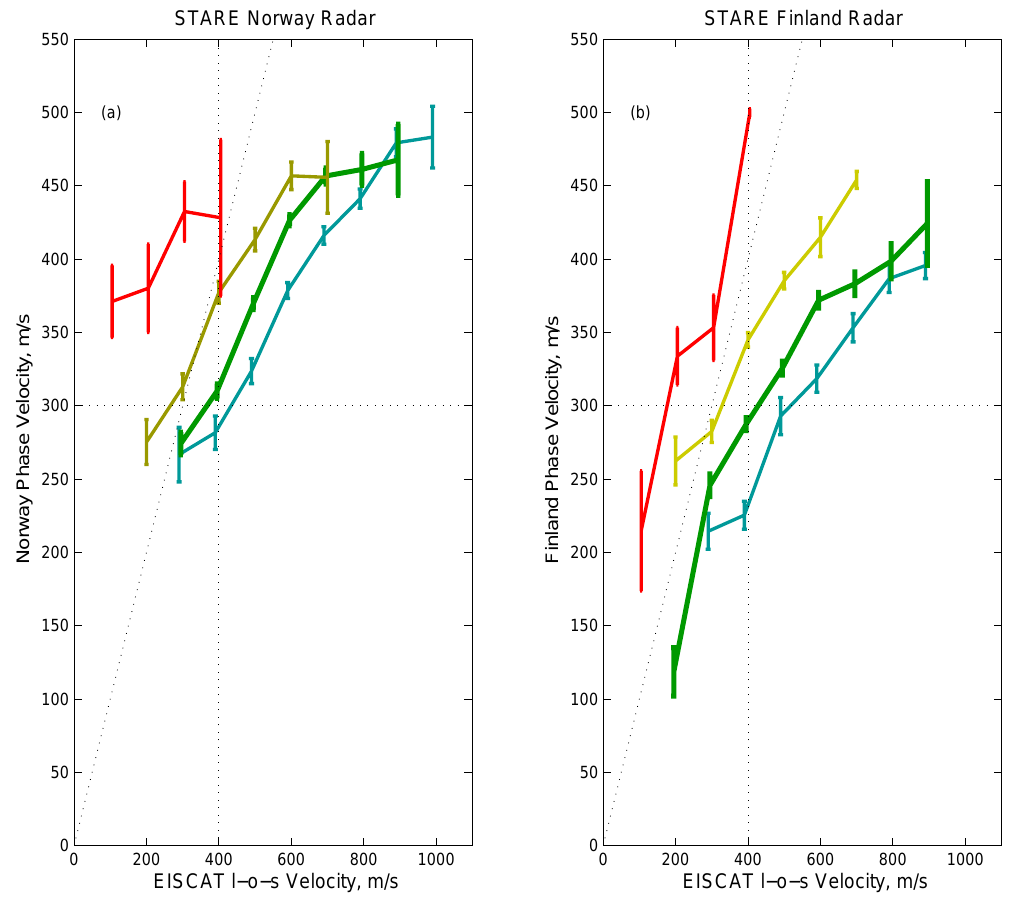
Fig. 5. Mean STARE irregularity drift velocities (from Fig. 3) as a function of EISCAT l-o-s electron drift velocity, V los Norway data and, (b) STARE Finland data, heavy green line is the flow angle of 2 = 60 ◦ , light-blue line for 50 ◦ , yellow-green line for 70 ◦ and red line for 80 ◦ ; bars are the standard deviation of mean STARE velocities , tilted dotted line is the bisector, horizontal dotted line of 300m/s divides two areas of low and moderate-high Doppler velocities, vertical dotted line of 400m/s divides two areas of smaller and greater than the smallest isothermal ion-acoustic speed C s ∼ 400m/s (Fig.